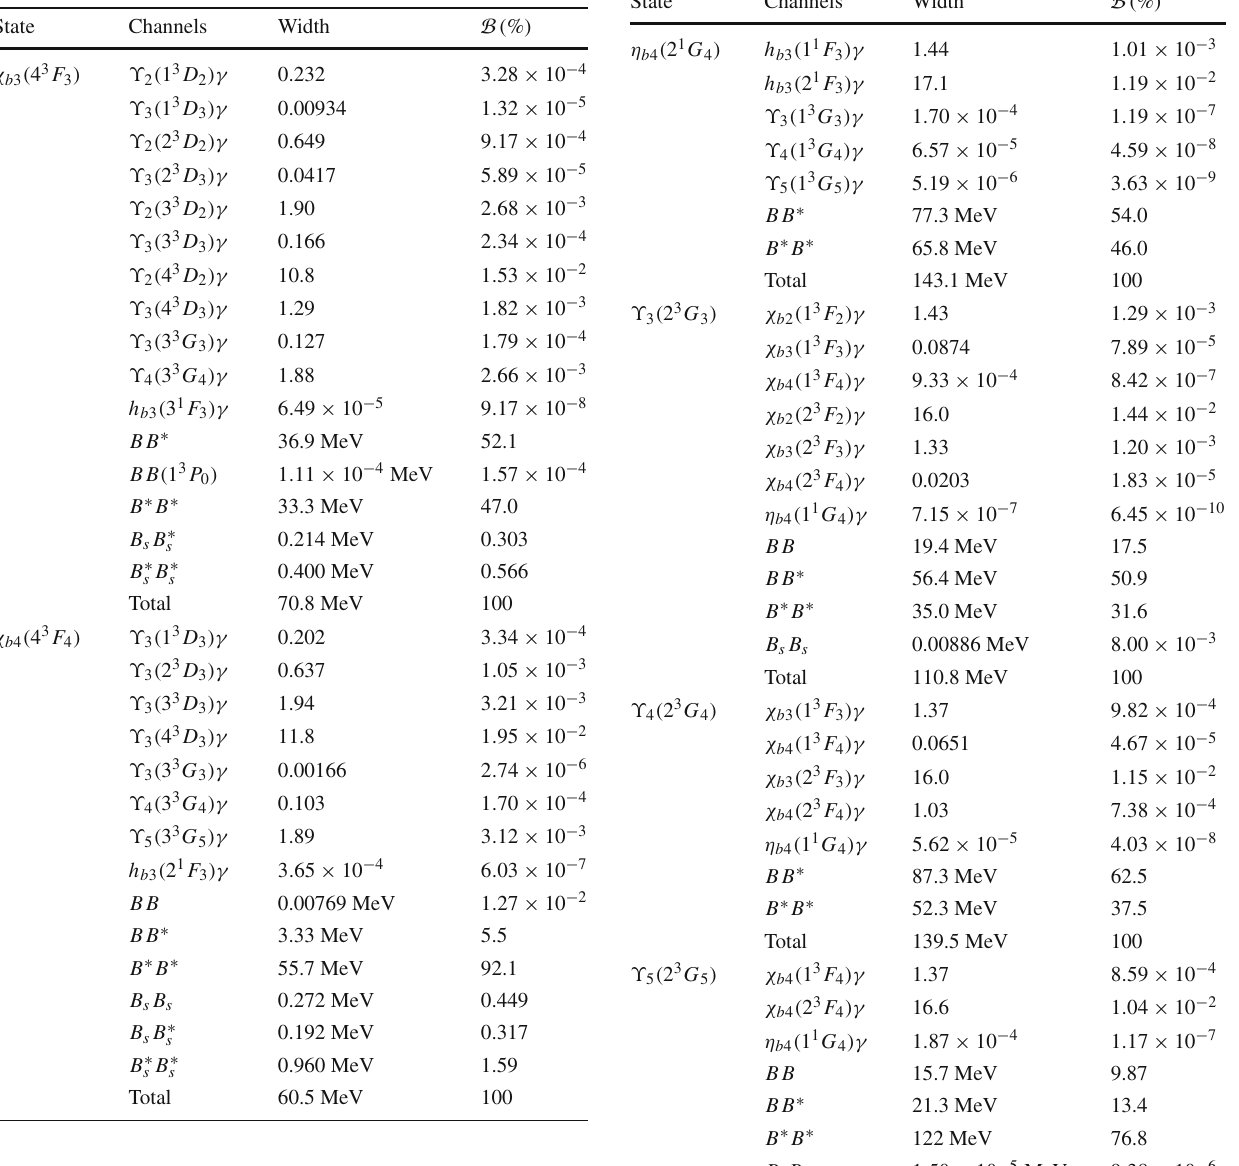
Table 37 Partial widths and branching ratios of OZI-allowed strong decay, annihilation decay, and radiative transition and the total widths for 4 3 F 3 and 4 3 F 4 bottomonium states. The width results are in units of keV